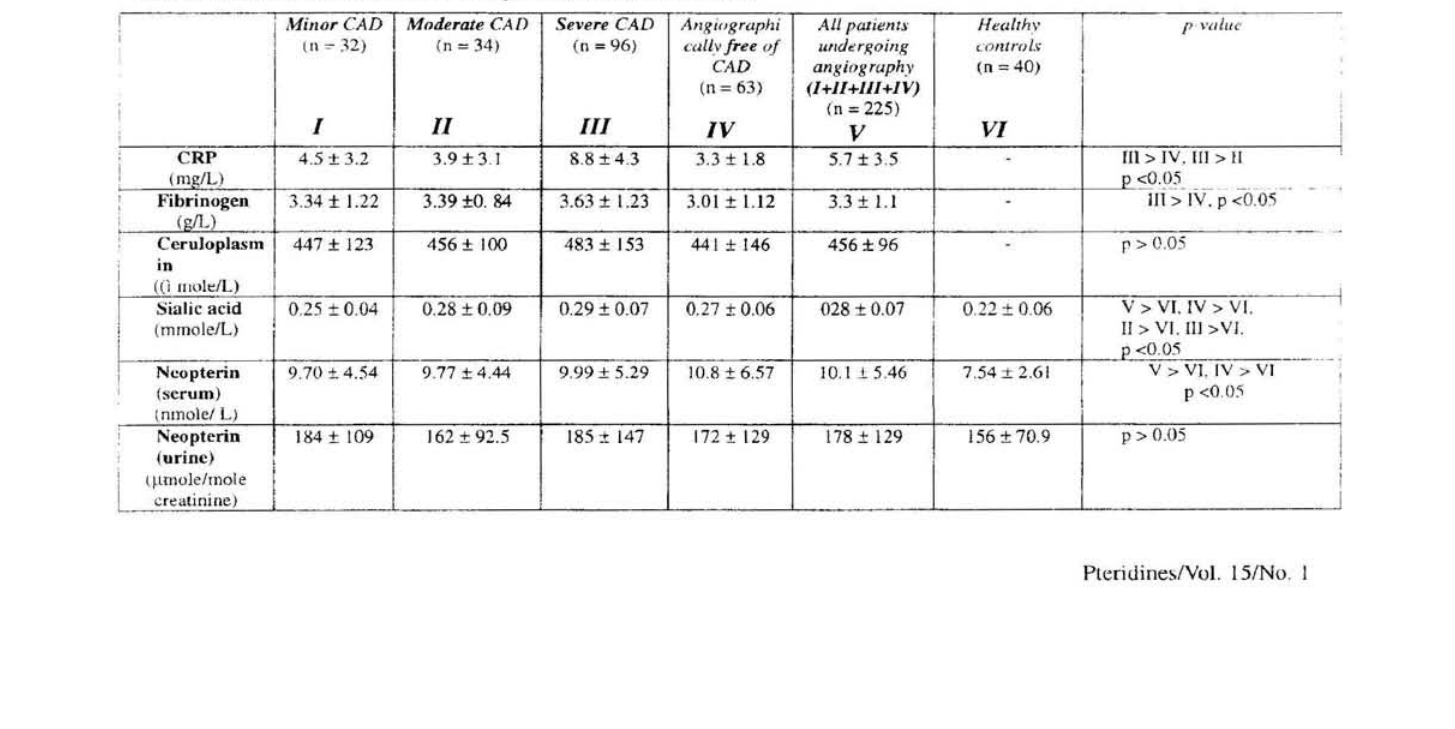
Table 3. Concentrations of acute phase proteins, sialic acid and neopterin in all patienis wilh coronary artery dis- ease (CAD) and controls. Data are presented as mean ±